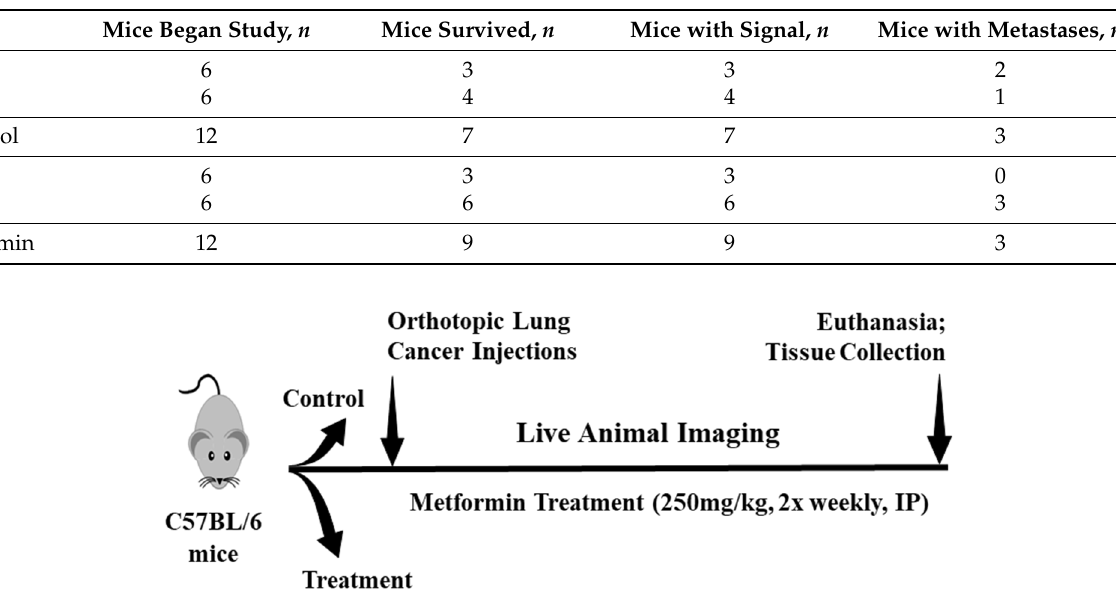
Figure 1. Experimental timeline for Lewis lung carcinoma development in an immunocompetent mouse model. Male ( n = 12) and female ( n = 12) C57BL/6J mice were implanted with 1000 Lewis